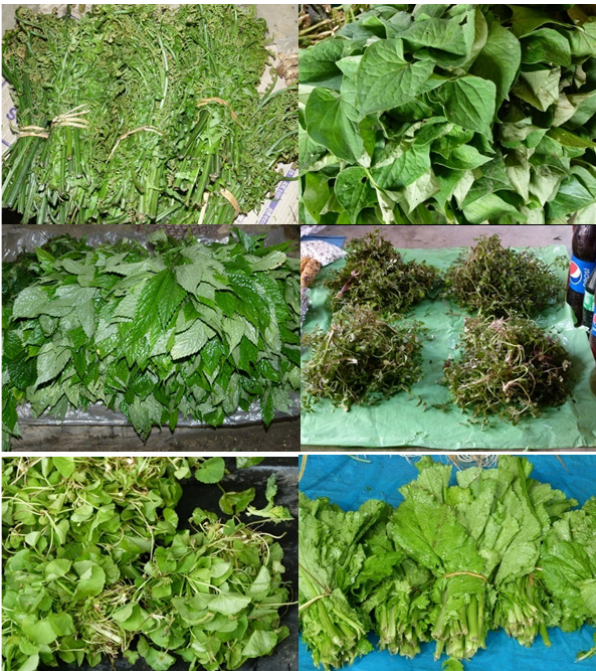
Fig. 8. Leafy NTFP of Ziro Valley. Left to right: first row - Hiika hamang ( Diplazium esculentum ) and Siya hamang ( Houttuynia cordata ); second row - Raru hamang ( Piper pedicellatum ) and Padii hamang ( Cardamine hirsuta ); third row - Ngliyang Khiko ( Centella asiatica ) and Giyang hamang (Brassica juncea var. rugosa )